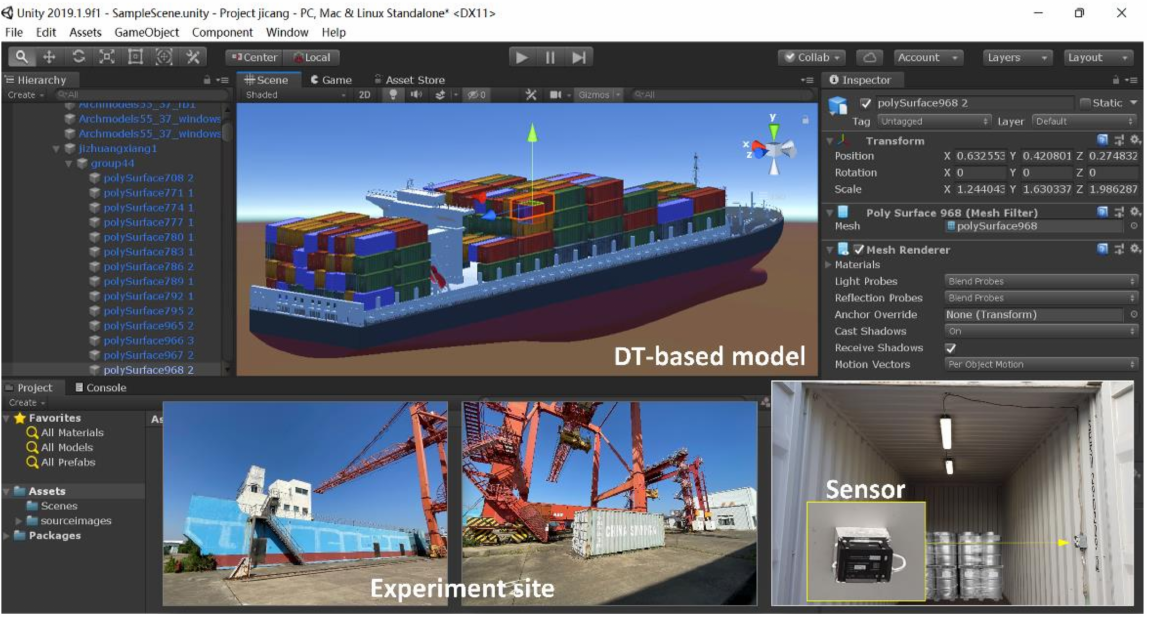
Figure 6. Integrated ship and cargo container with DT modeling combing